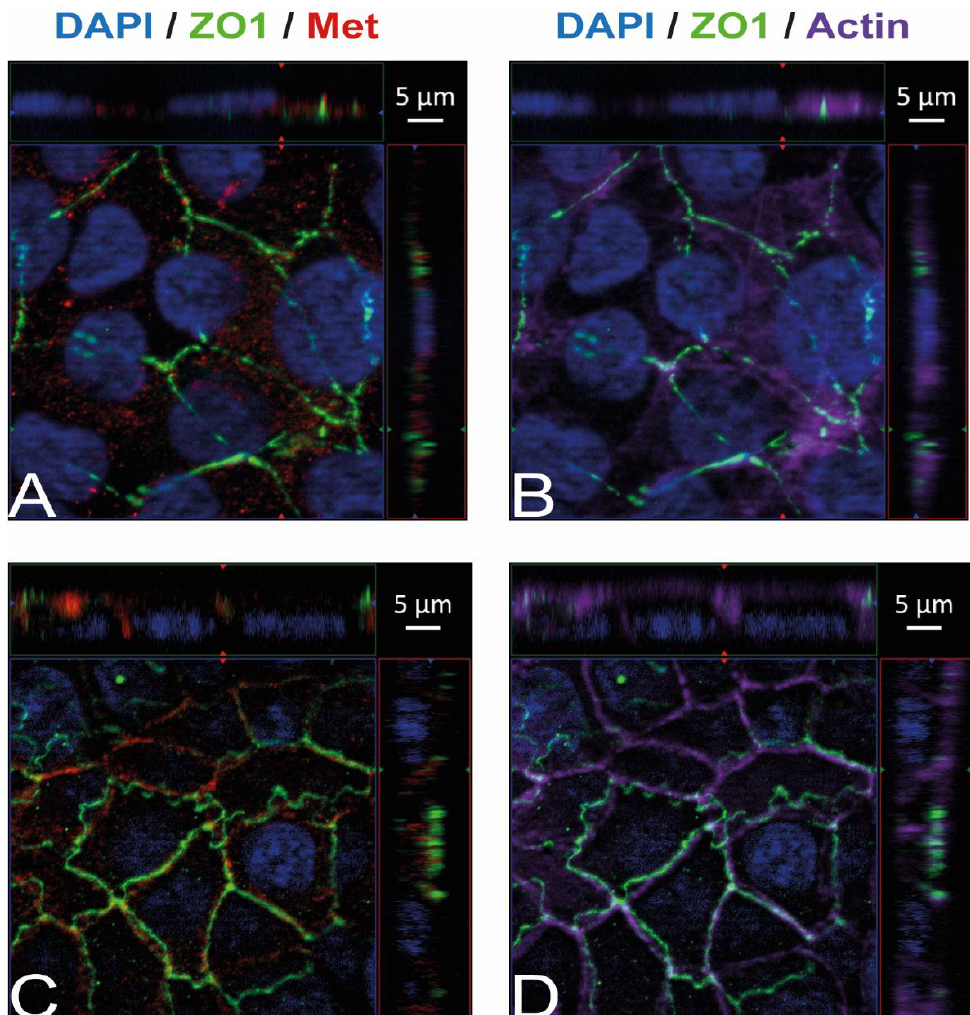
oriented toward the top of the top part and towards the right of the right part of each panel, respec- tively.